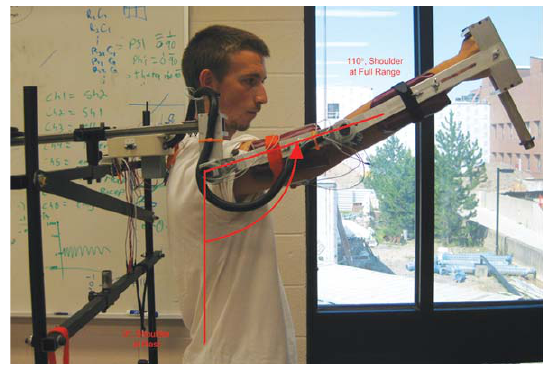
Fig. 5. Range of motion for single joint shoulder